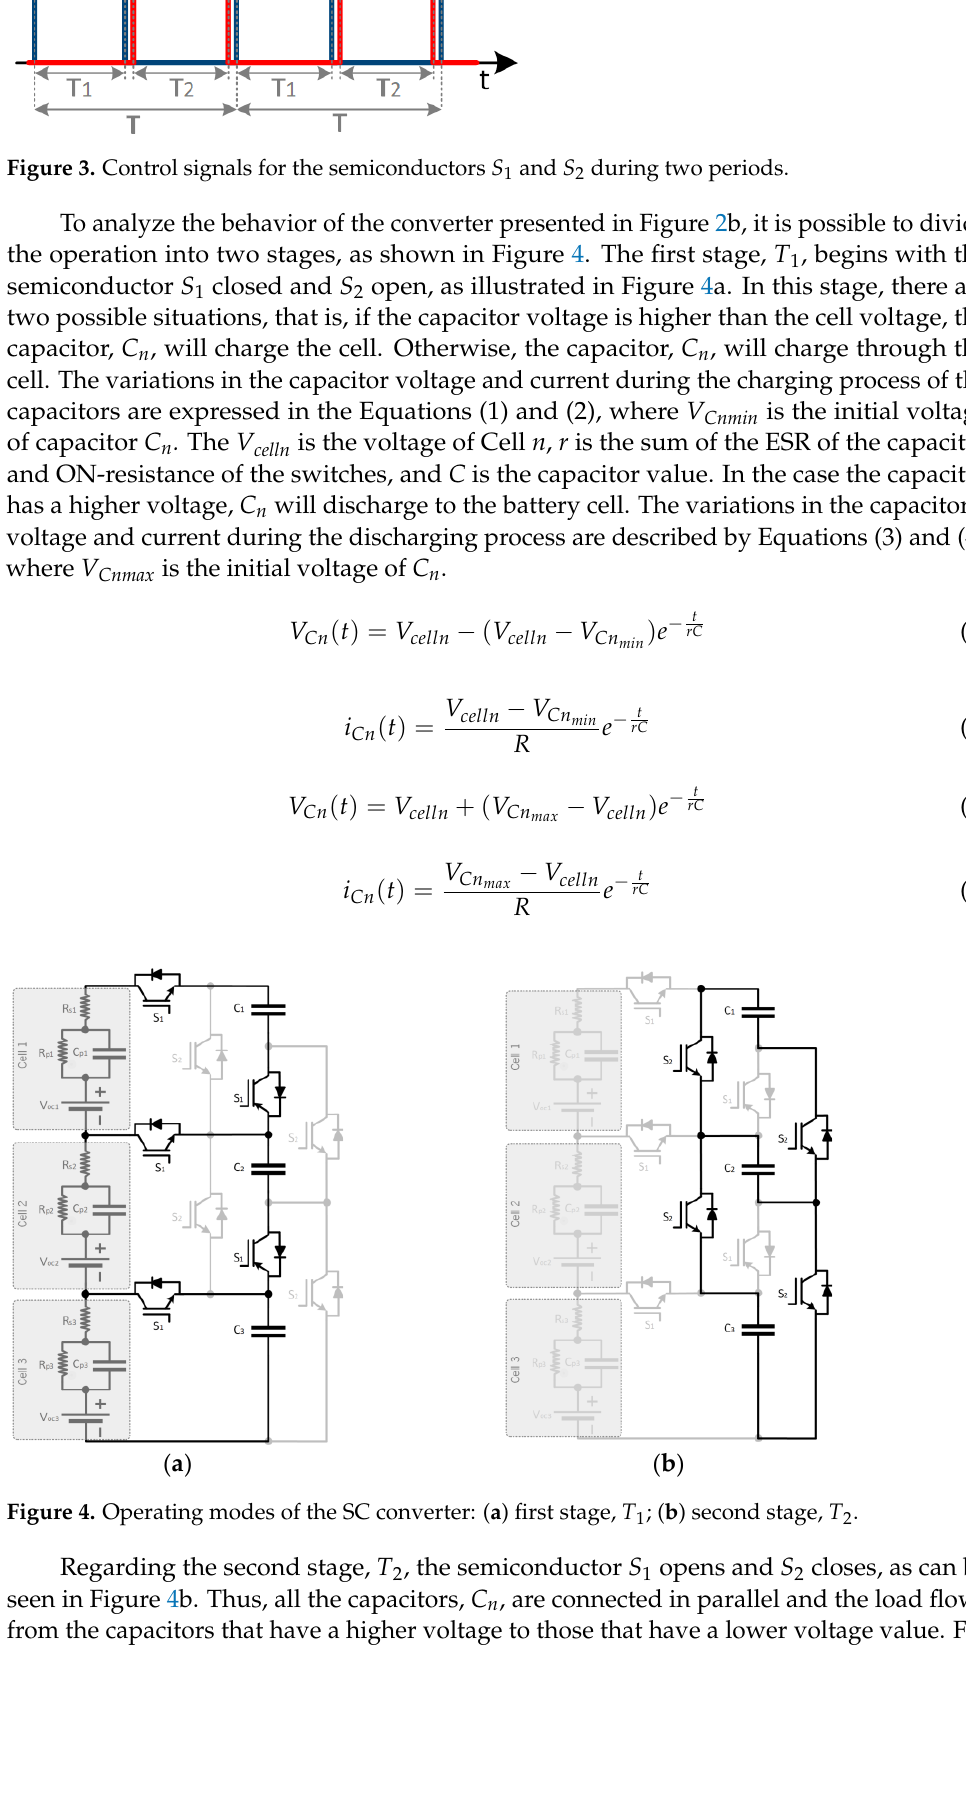
1 ; ( b ) second stage, T 2